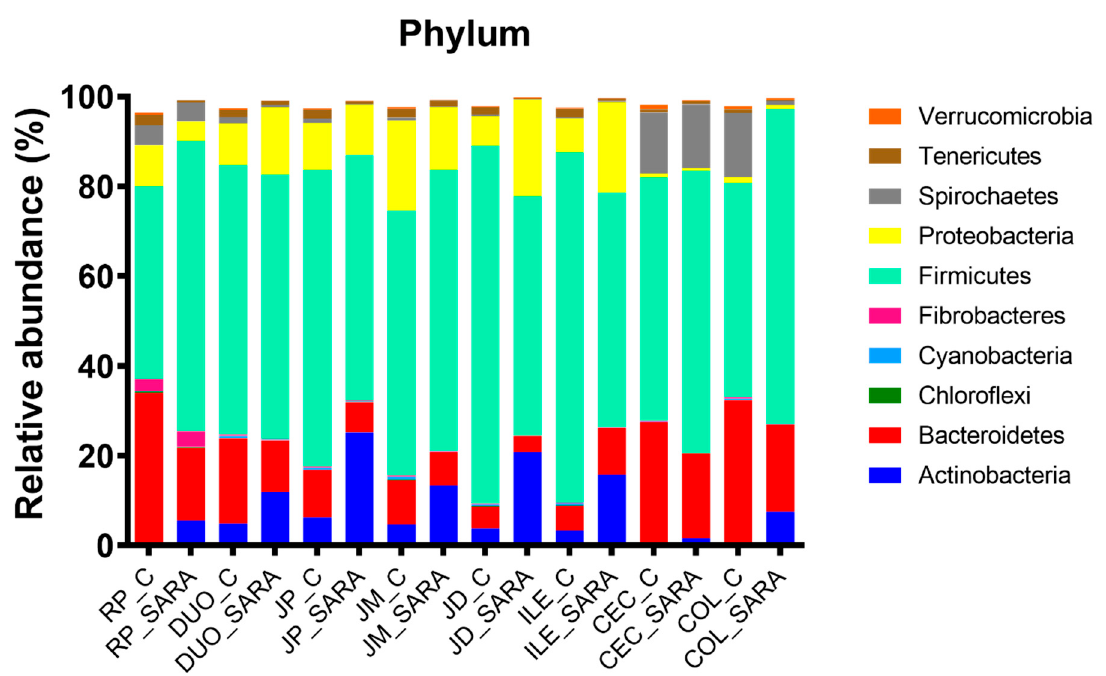
Figure 3. Relative abundances of abundant phyla, assessed by treatment (C = control, S = SARA), for each site in the digestive tract. RP = rumen, DUO = duodenum, JP = proximal jejunum, JM = middle jejunum, JD = distal jejunum, ILE = ileum, CEC = cecum, COL = colon.